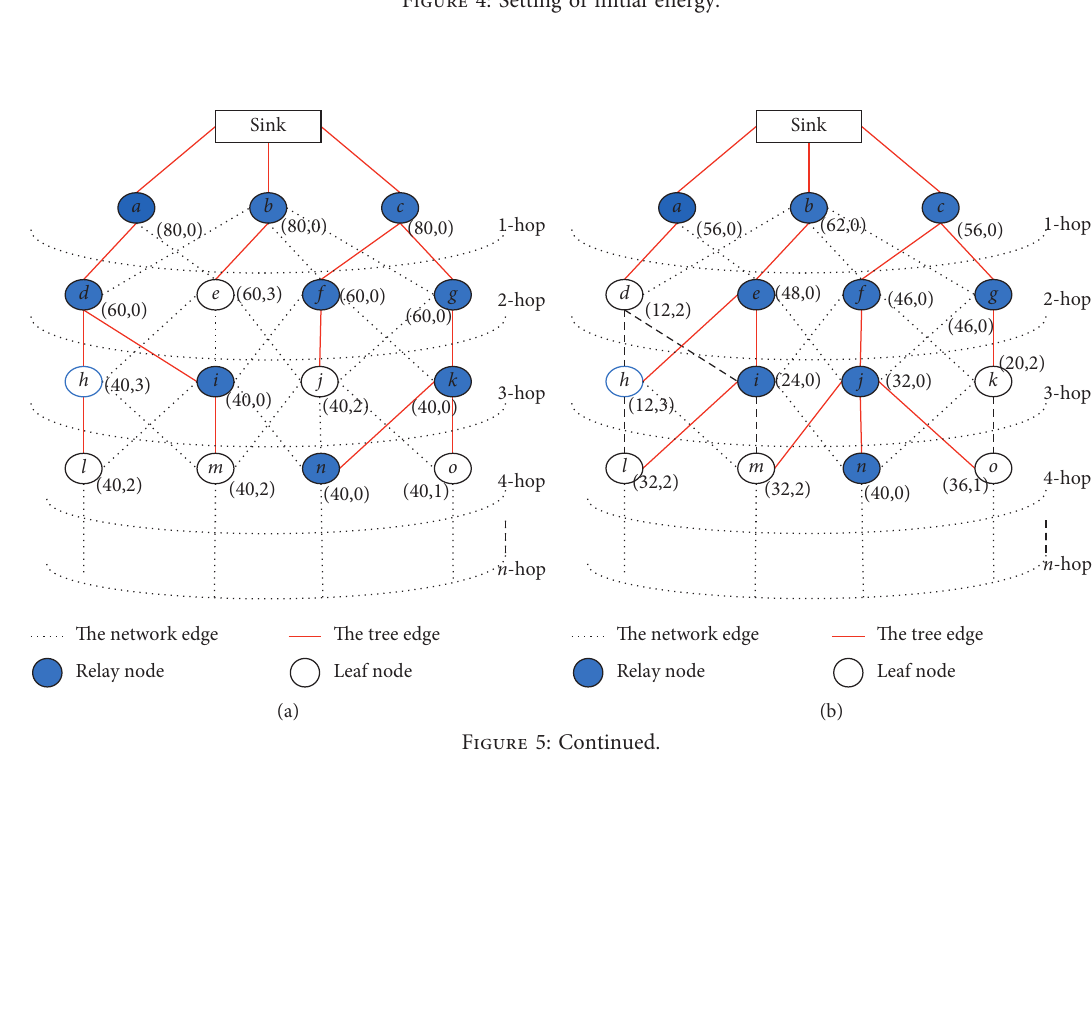
Figure 4: Setting of initial energy.